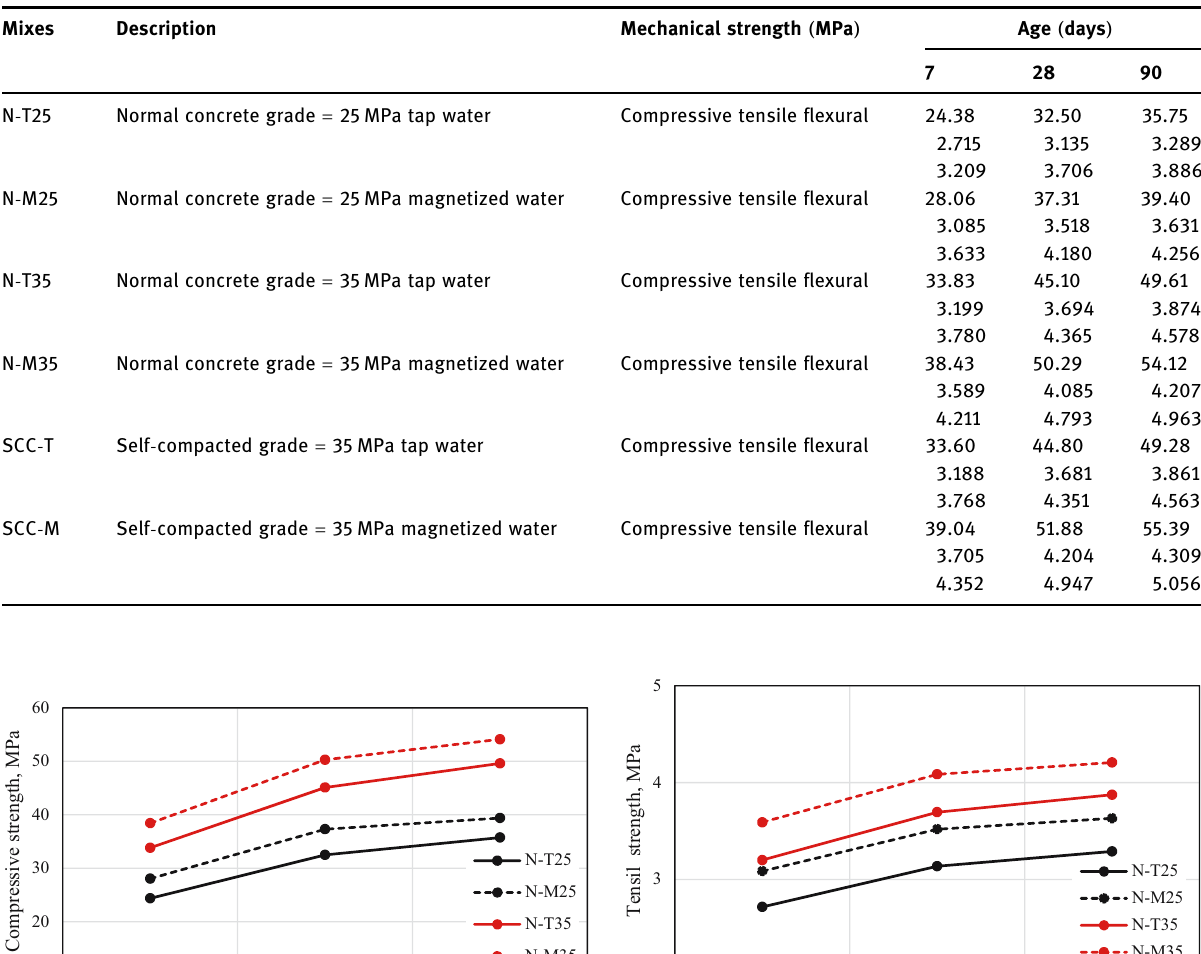
Table 8: Concrete ’ s mechanical properties ( MPa )